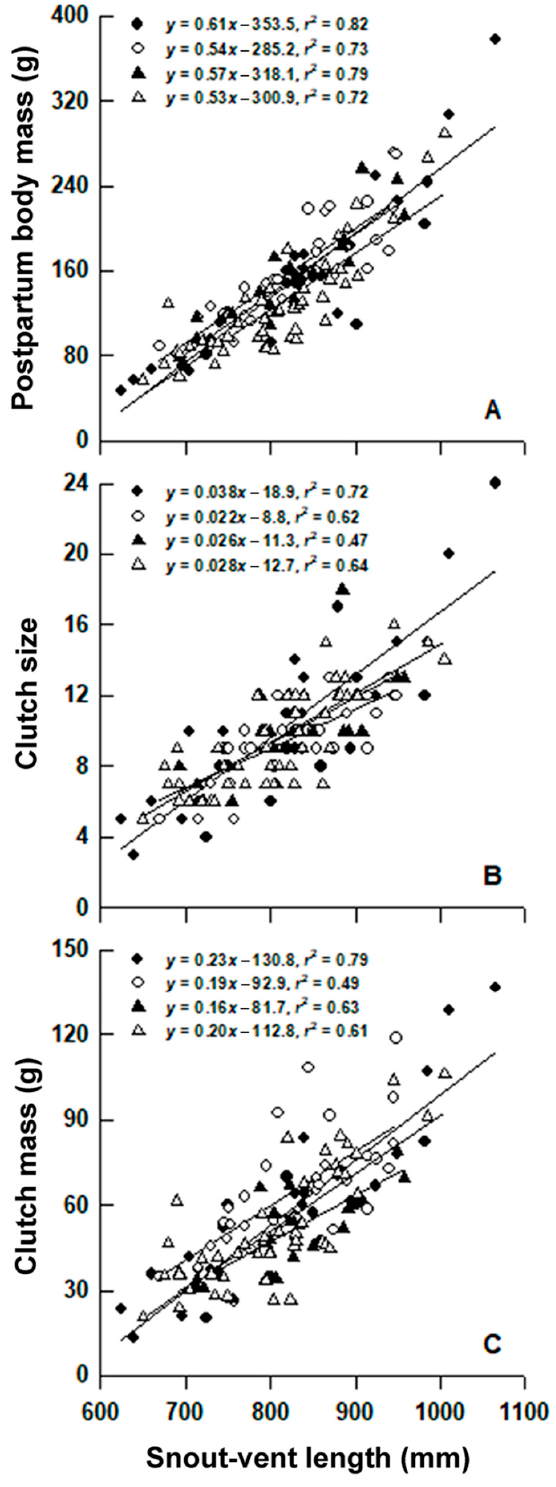
Figure 3. Postpartum body mass ( A ), clutch size ( B ), and clutch mass ( C ) in relation to female snout vent length. Regression equations and coefficients are given in the fi gure. ● : 1999; ○ : 2010; ▲ : 2011; △ : 2014. ◆ : 1999;